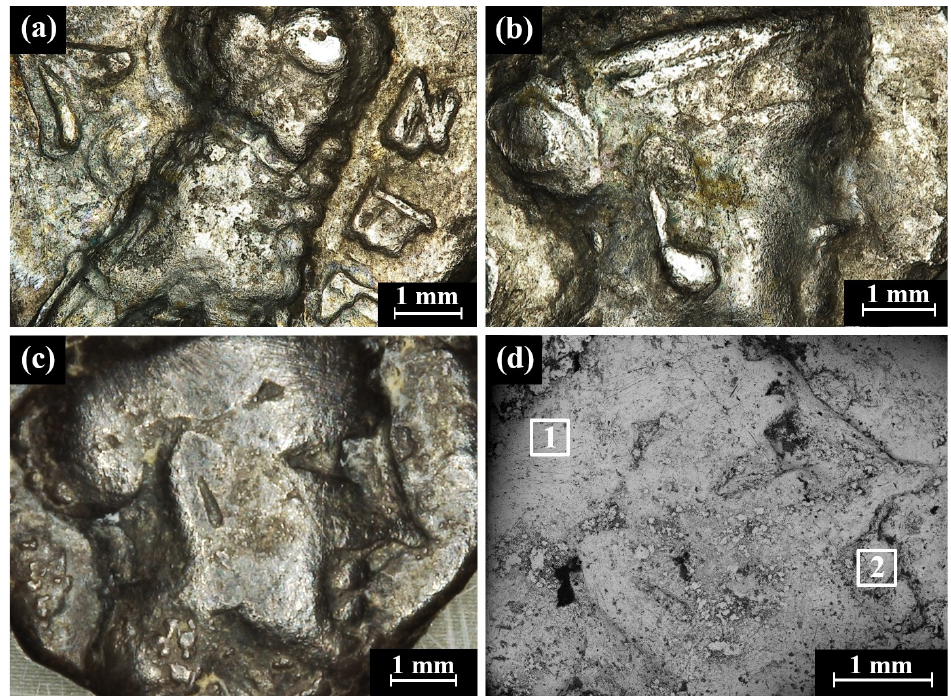
Figure 5. Images of the Yehud gerah Type 5 O1/R1 coins: ( a ) IAA 138139 reverse, depicting an owl (multi-focal LM), and ( b – d ) obverses of the coin depicting the head of Athena; ( b ) IAA 138139 (multi-focal LM); ( c ) IMJ 27398 (multi-focal LM); and ( d ) IMJ 27398 (SEM, BSE mode), where the white squares (areas 1 and 2) were examined by EDS analysis (the brighter areas are better preserved metal than the darker areas).